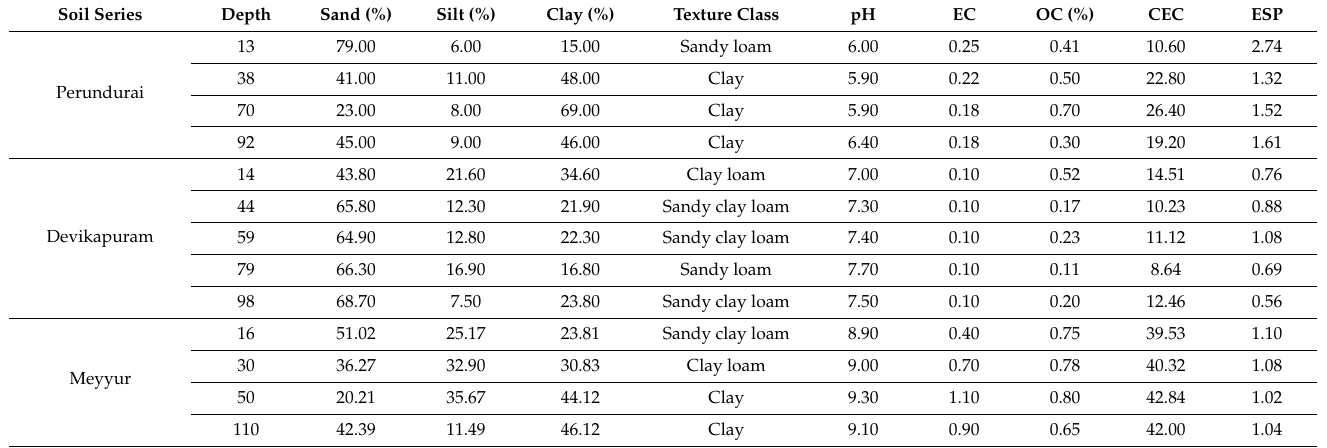
Table A1. Predominant soil series information of Tiruvannamalai district used in S-built tool of DSSAT